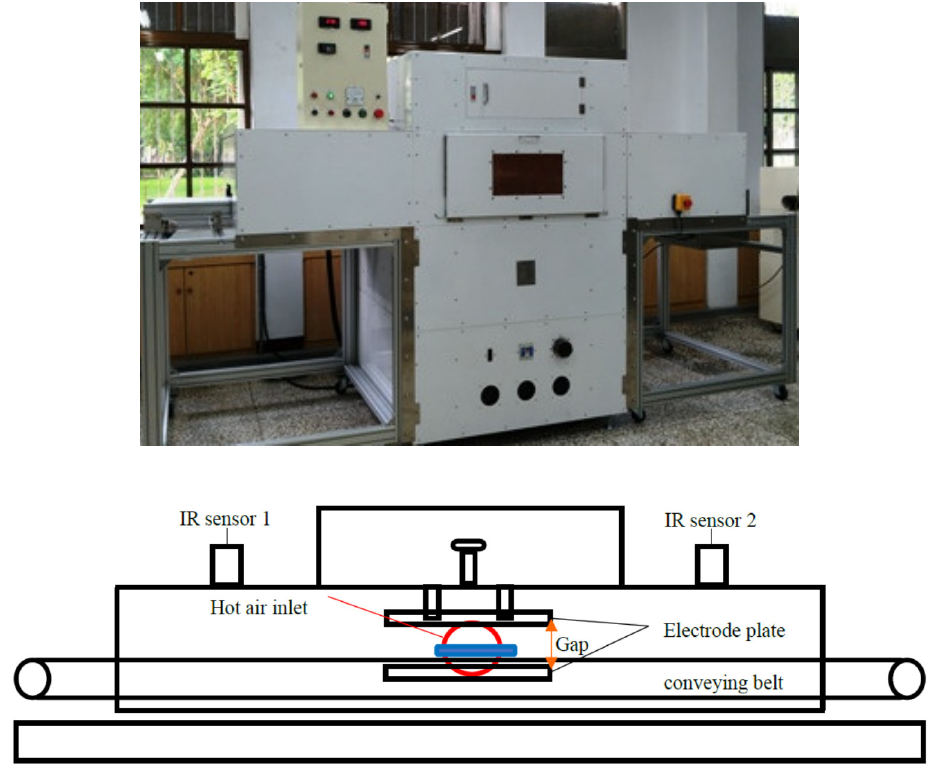
Figure 1. Schematic view of 10 kW, 40.68 MHz continuous radio frequency (RF) (10 kW, 40.68 MHz) with hot air heating system.